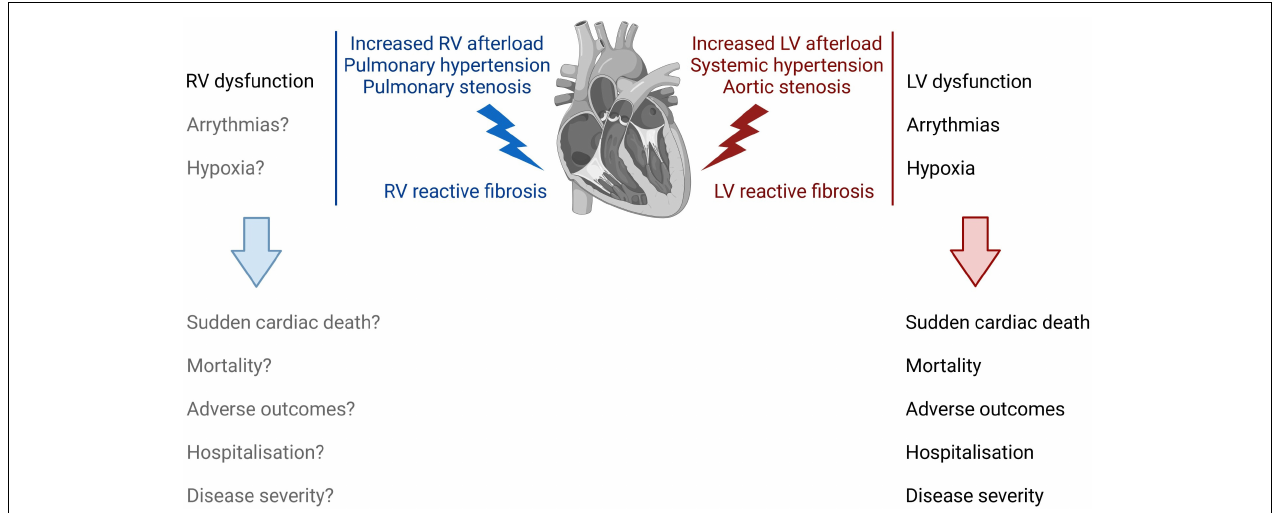
FIGURE 2 | The impact of right and left ventricular reactive fibrosis on cardiac function, physiology, and clinical outcome. Increased LV afterload induces LV reactive fibrosis (right) that correlates with LV dysfunction, and increases the risk for arrythmias and for hypoxic conditions in the LV. Together, these changes in the LV increase the risk for sudden cardiac death, increase patient mortality, and associate with adverse outcomes, hospitalization, and disease severity. RV reactive fibrosis (left) following an increased RV afterload leads to increased RV stiffness and dysfunction. However, the role of fibrosis in the development of RV failure is not fully